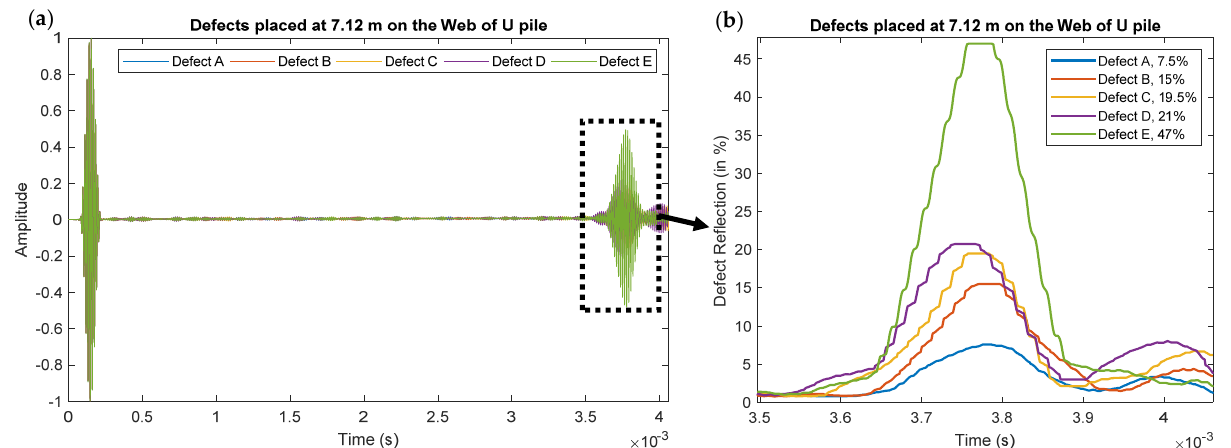
Figure 18. ( a ) Results obtained from the defects placed at 7.12 m on the web of the U-pile. ( b ) Defect reflection results from the respective defects.